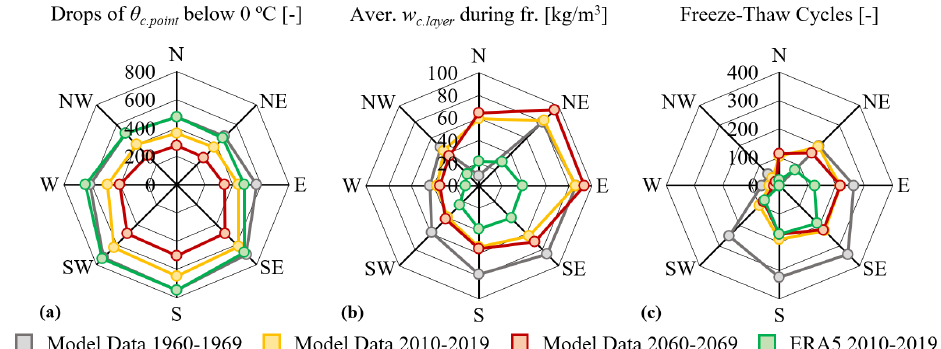
Figure 8. (a) Number of events during which the temperature at the control point 2.5mm in depth from the outer side of the simulated wall drops below 0 ◦ C. (b) Average moisture content at the 5mm layer at the outer side of the wall during the periods that the θ controlpoint is below 0 ◦ C. (c) Total number of freeze-thaw cycles according to the material response-based index.